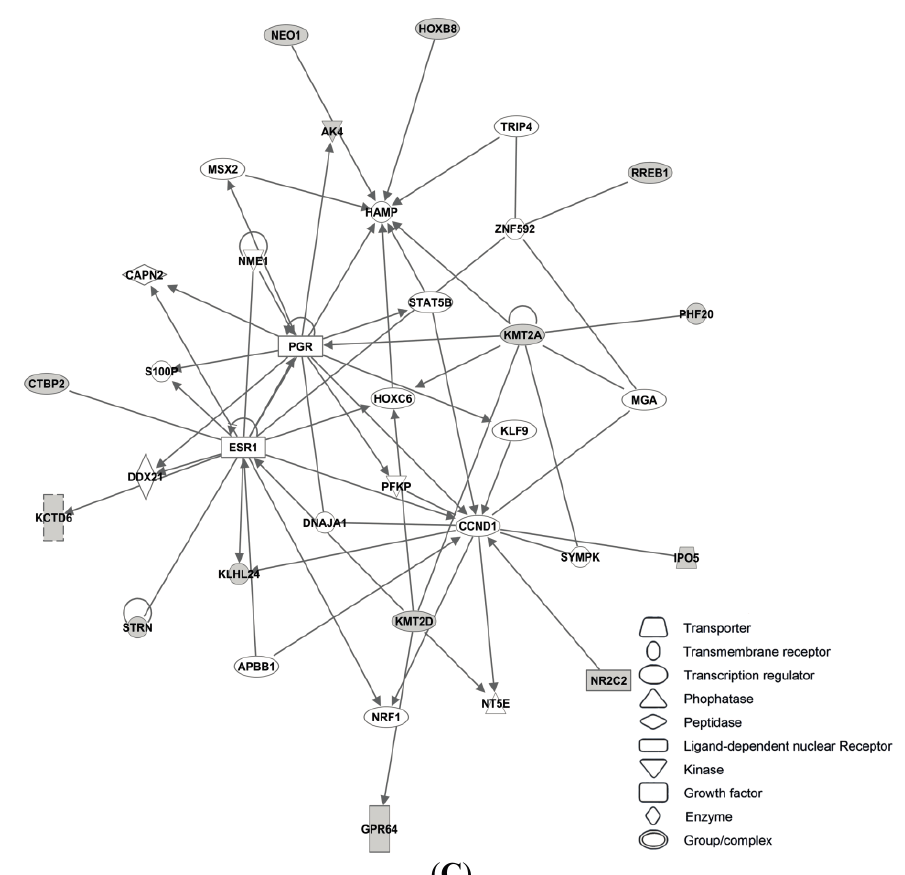
Figure 5. IPA networks for miR-30c, network ( A ), miR-126, network 1 ( B ) and miR-342, network 2 ( C ), centered on the estrogen receptor (ESR1). These networks created by IPA, comprise networks with ER as an indirect target (miR-126 and miR-342), whereas miR-30c has an ER-complex as an indirect target. Shaded boxes refer to direct targets whilst clear boxes refer to indirect targets of the specific